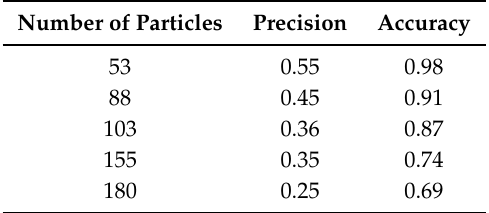
Table 1. Accuracy and precision of the